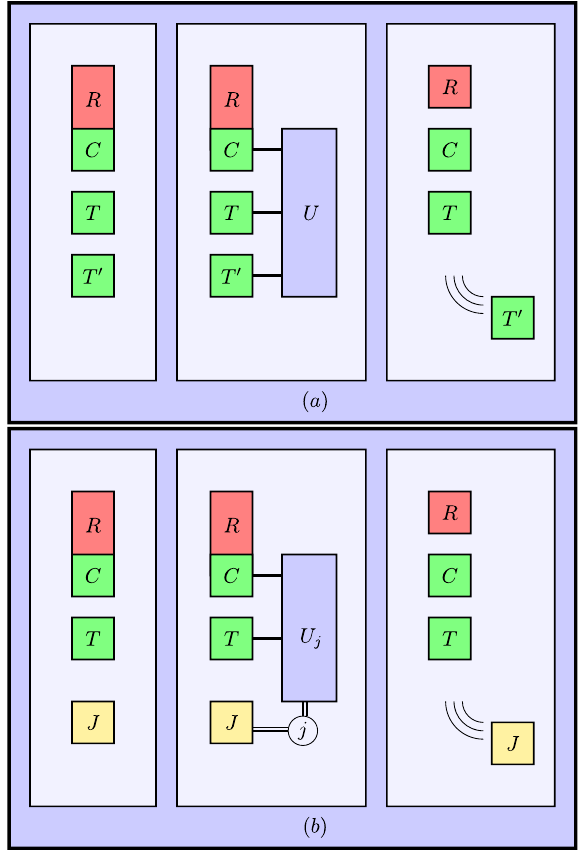
Fig. 1 Decoupling method. Process of removing the quantum correlation between two registers R and C , by means of quantum operations. The cost of performing a decoupling operation is characterized by the size of the register that must be discarded, in order to implement the operation. In Fig. a , the discarded register is T 0 and the operation performed on CTT 0 is a global unitary U . In Fig. b , the register J (that is eventually discarded) is maximally mixed to begin with and the operation performed is a controlled unitary. Thus, J can be viewed as a classical noise 61 . While the operation in Fig. b is a special kind of operation in Fig. a , the following equivalence holds due to the duality between teleportation 62 and superdense coding 63 . For every operation in Fig. a with log j T 0 j qubits that are discarded, there is an operation in Fig. b with 2log j T 0 j bits of noise. Moreover, for every operation in Fig. b with log j J j bits of noise, there is an operation in Fig. a where 1 qubits that are discarded.